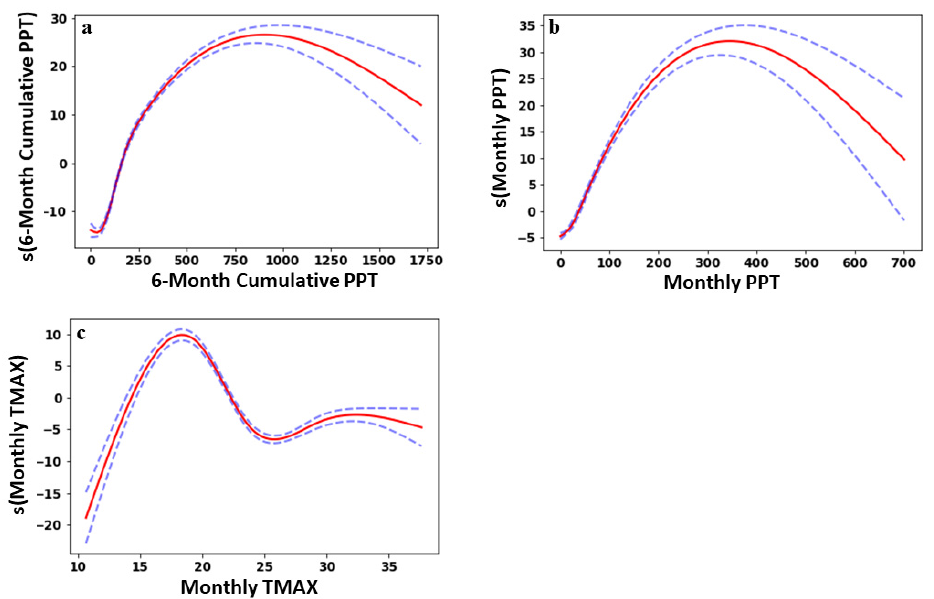
Figure 3. Smoothed coefficients of ( a ) cumulative precipitation over the prior six months, ( b ) monthly precipitation (2 month lag), and ( c ) mean maximum temperature (2 month lag) developed for GAM models used to predict LFM. Smoothed values ( y -axis) represent contributions of each parameter to estimated LFM throughout the observed parameter space ( x -axis). Solid red lines indicate smoothed coefficients. Dashed blue lines indicate 95% confidence intervals for each smoothed coefficient